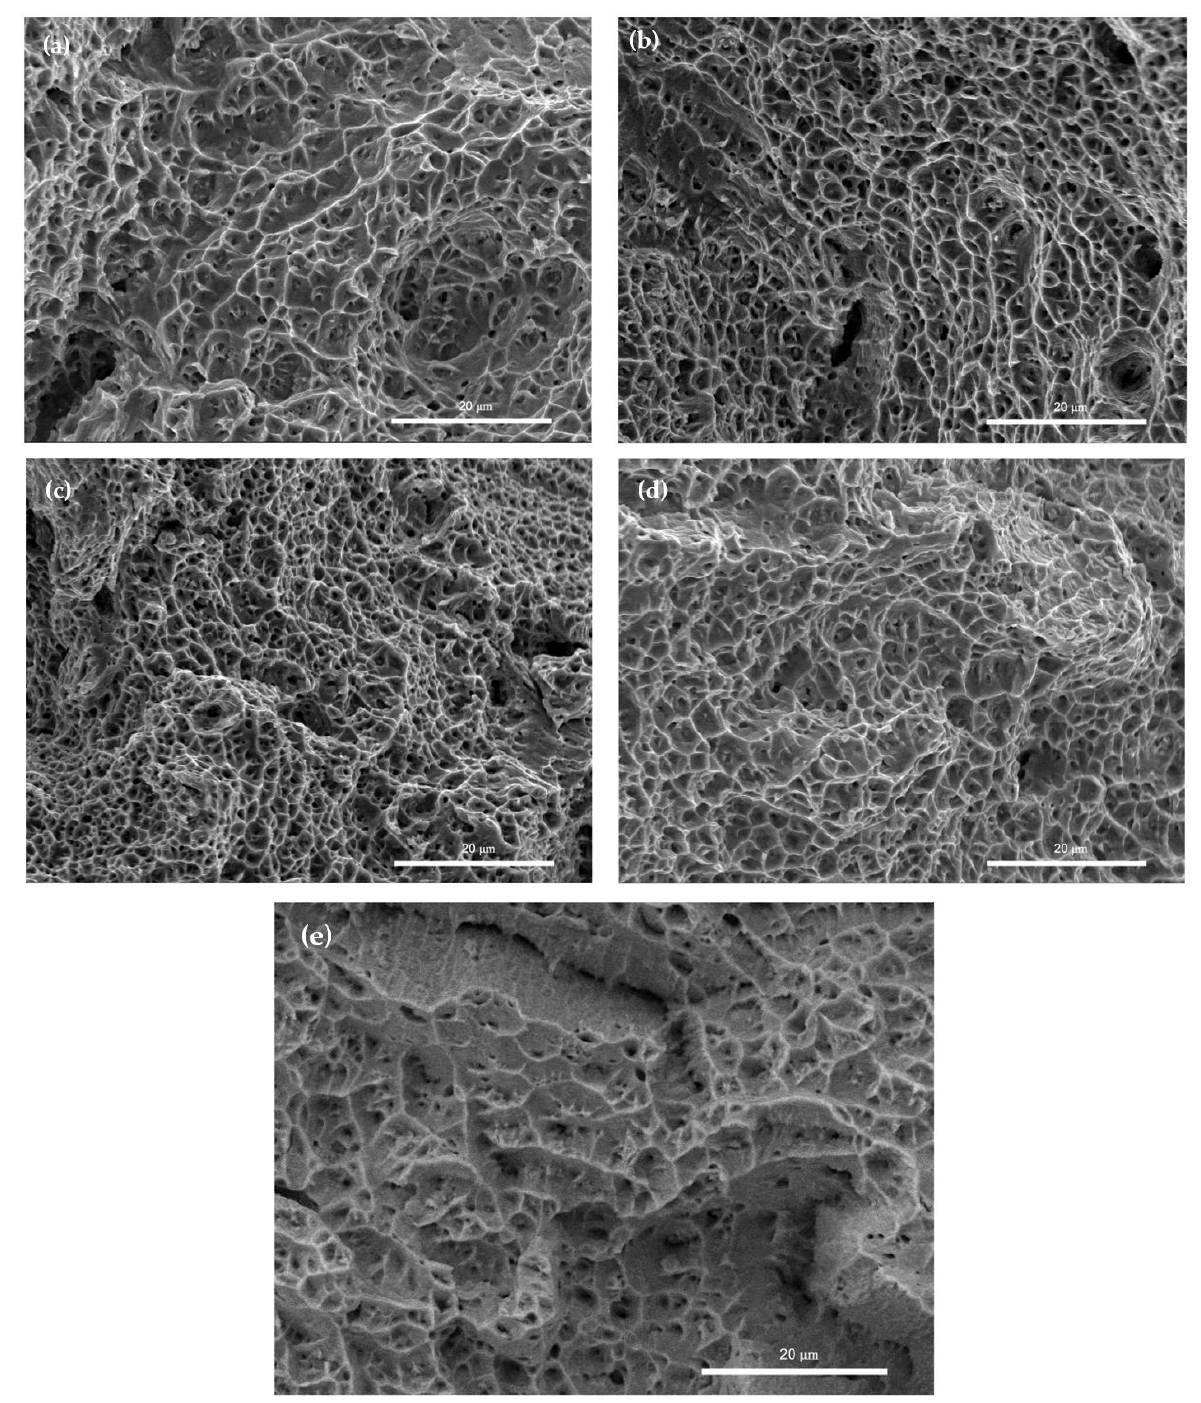
Figure 14. LP-DED heat-treated SEM fractography images: ( a ) 350 W, ( b ) 750 W, ( c ) 1070 W, ( d ) 2000 W, ( e ) 2620 W.